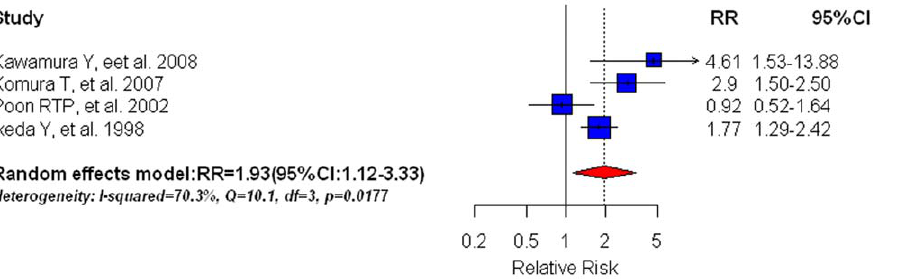
Figure 5. Summary estimate of relative risk (RR) for HCC recurrence-free survival (RFS) in HCC patients with pre-existing diabetes mellitus in comparison with non-diabetic patients. Squares represent study-specific estimates (size of the square reflects the study-specific statistical weight, i.e. inverse of the variance); horizontal lines represent 95% CIs; diamonds represent summary estimates with corresponding 95% CIs.